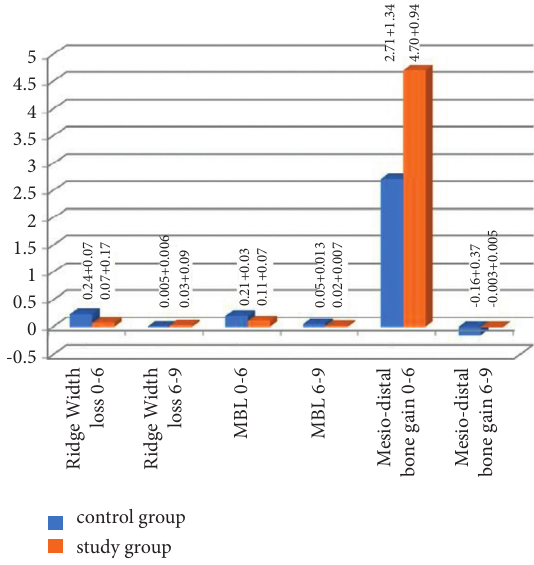
Figure 9: Bar chart representing the comparison of the mean and standard deviation of radiographic measurement between the two studied groups in different observation